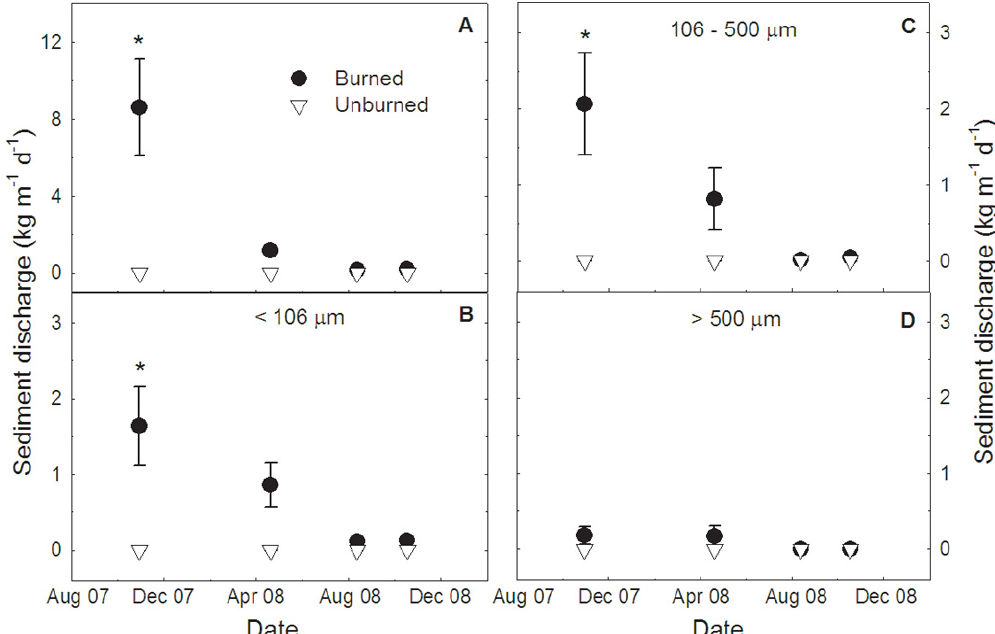
Fig. 2. Mean ( ± SE) sediment discharge in the burned (filled circles) and unburned (open triangle) area during the first year following the Twin Buttes fire. Total sediment discharge (A) , sediment discharge for the suspension ( < 106µm) size class (B) , saltation (106–500µm) size class (C) and the largest size class of eroded sediment (D) . Values for each sampling period consist of 3–5 height-integrated flux measurements (* denotes significant site differences at P < 0 .